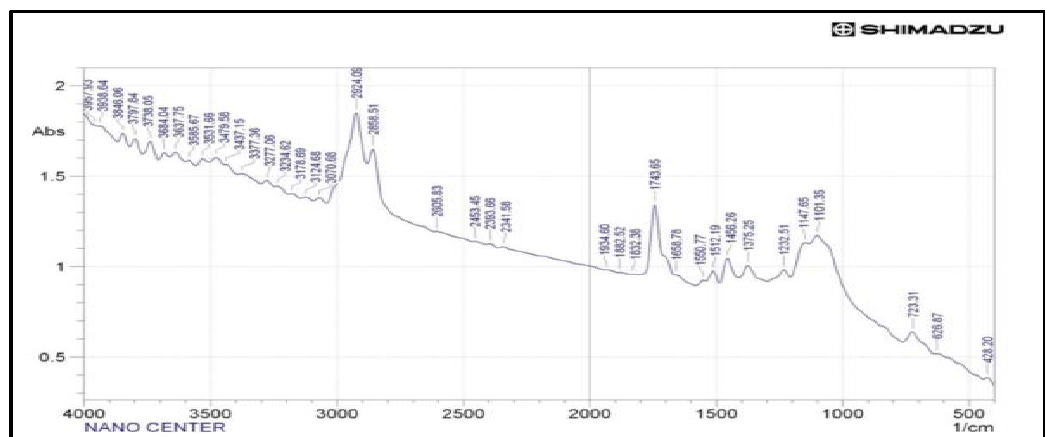
Figure 12. FTIR spectrum of the physical mixture of drug, EC and HPMC 15cps.